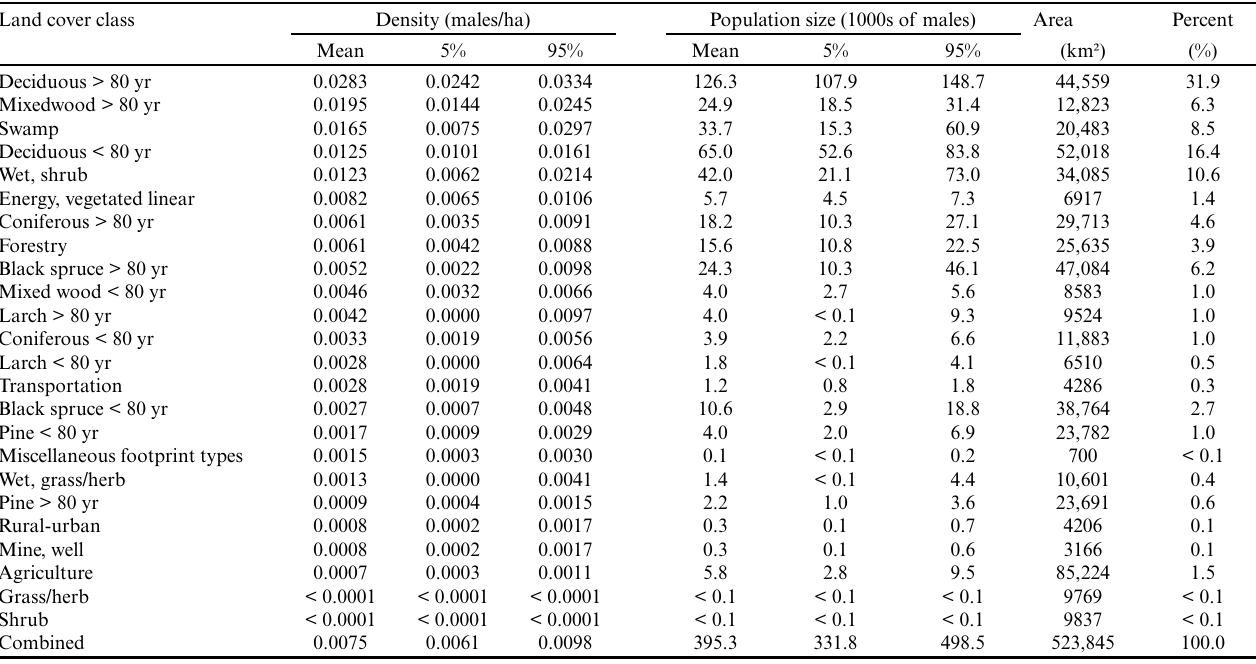
Table 3 . Predicted population density (males/ha) and population size (singing males in thousands) of Canada Warbler in northern Alberta summarized by land cover types (base year for human footprint is 2012). Area gives the total extent of land cover types in the study area, and percent reflects population size relative to the combined total population size. Bootstrap averaged means and lower (5%) and upper (95%) prediction intervals are provided corresponding to 90% coverage. Land cover types are ranked by mean density.